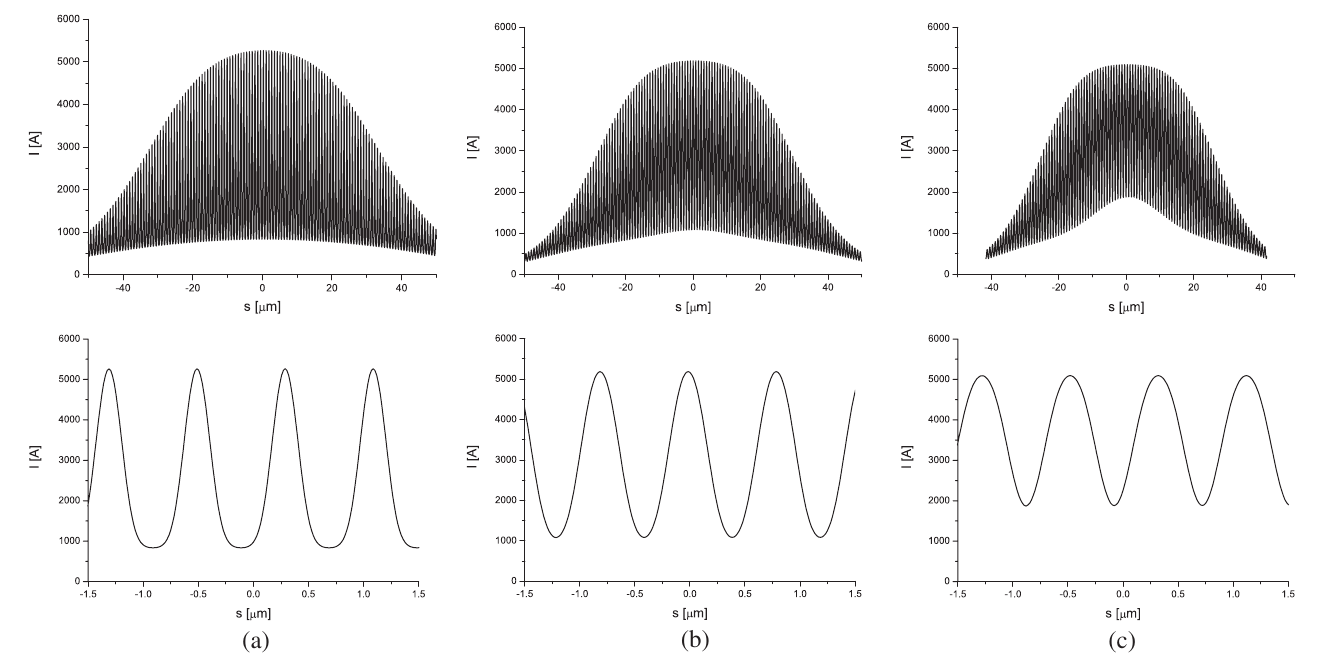
FIG. 5. The current distribution after BC3 (upper plots) and its enlarged fraction (lower plots) for (cid:1) C=C 0 ¼ (cid:1) 20% (a), (cid:1) C=C 0 ¼ 0 (b), and (cid:1) C=C 0 ¼ 20% (c).